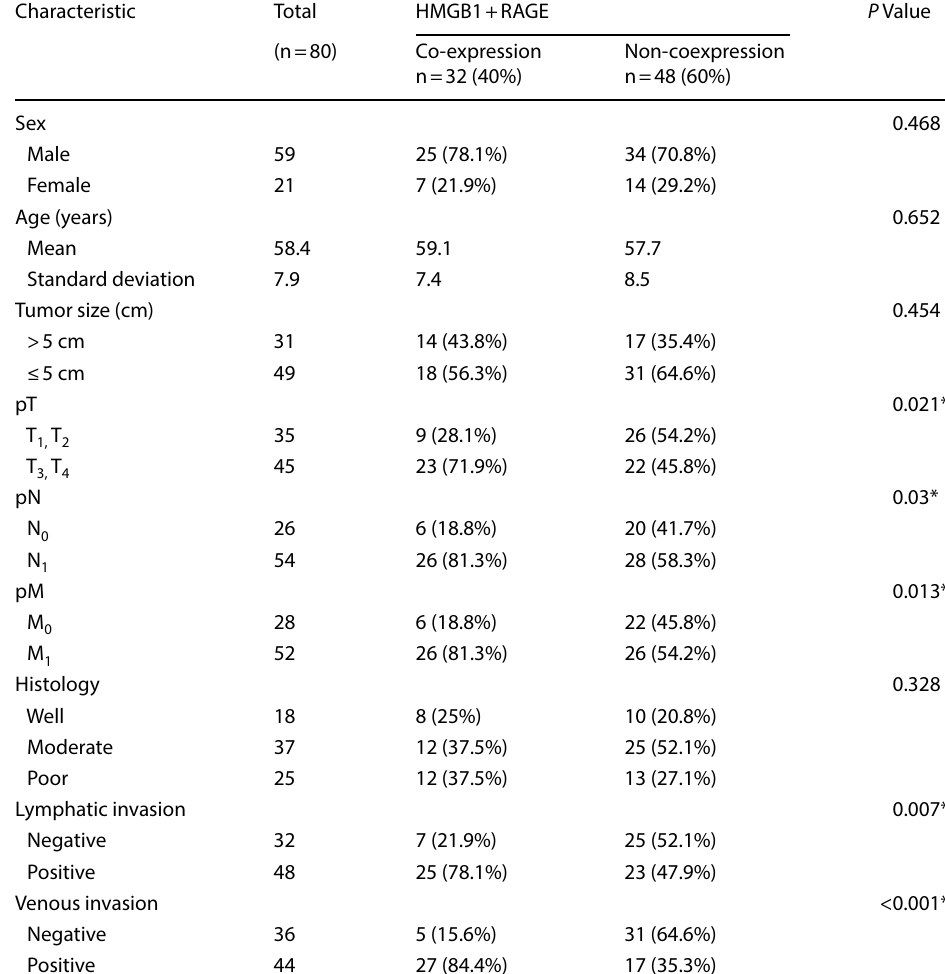
Table 5 Correlation between co-expression of HMGB1 and RAGE in ESCC expression and clinicopatholological characteristics of the